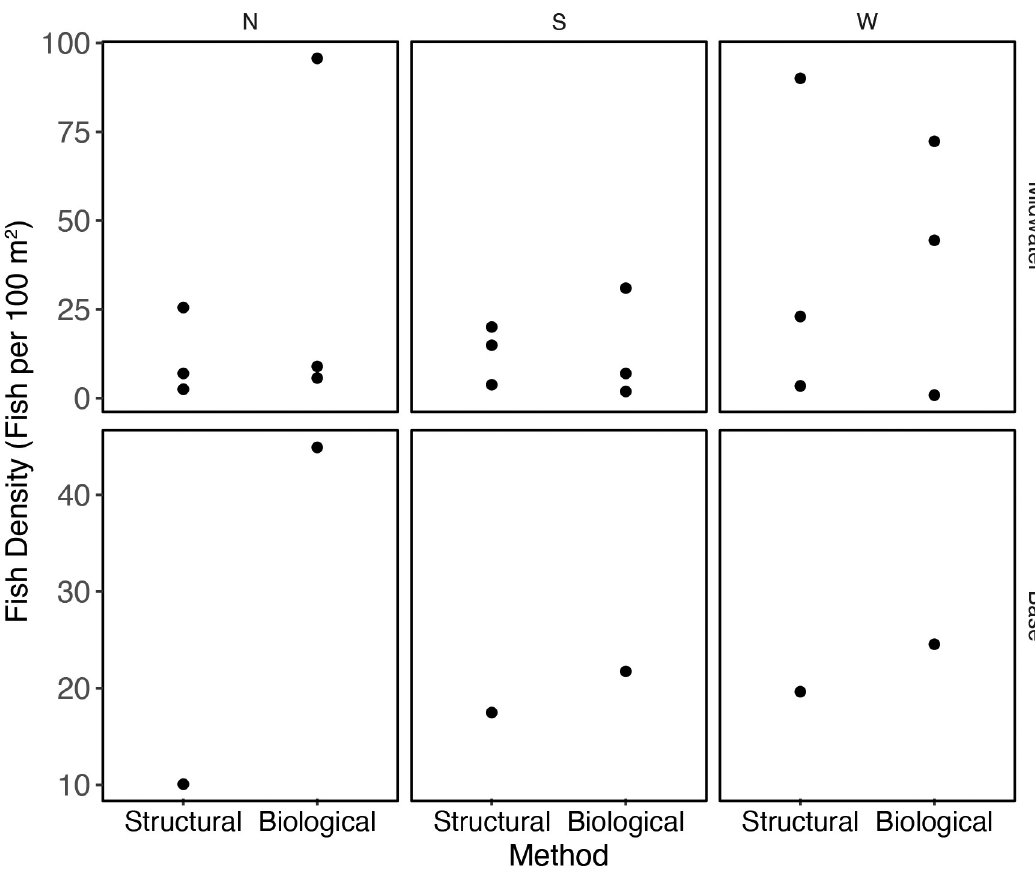
Fig 5. Densities of all fishes combined in the midwaters and at the base of Platform Harmony, by method and crossbeam side (N = north, S = south, W = west).